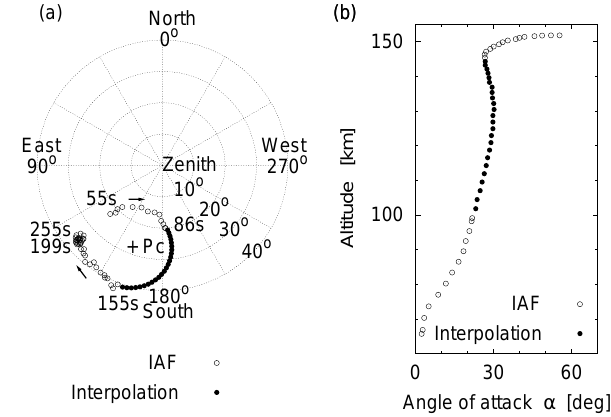
Fig. 2. (a) Direction of the rocket axis. The IAF measure- ments (open circles) were obtained only 57–86 and 155–255s after the launch, and the missing data during 86–155s are interpolated (closed circles) by assuming a stable precession, whose center is indicated by “Pc”. Arrows indicate the direction of the precession. (b) Angle of attack variation in the ascent derived from the attitude data in Fig.